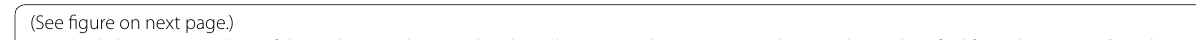
reactor(See figure on next Fig. 3 Phylogenetic analysis of the N-damo archaea and N-damo bacteria in the system. a N-damo archaea identified from the reactor; b N-damo bacteria identified from the